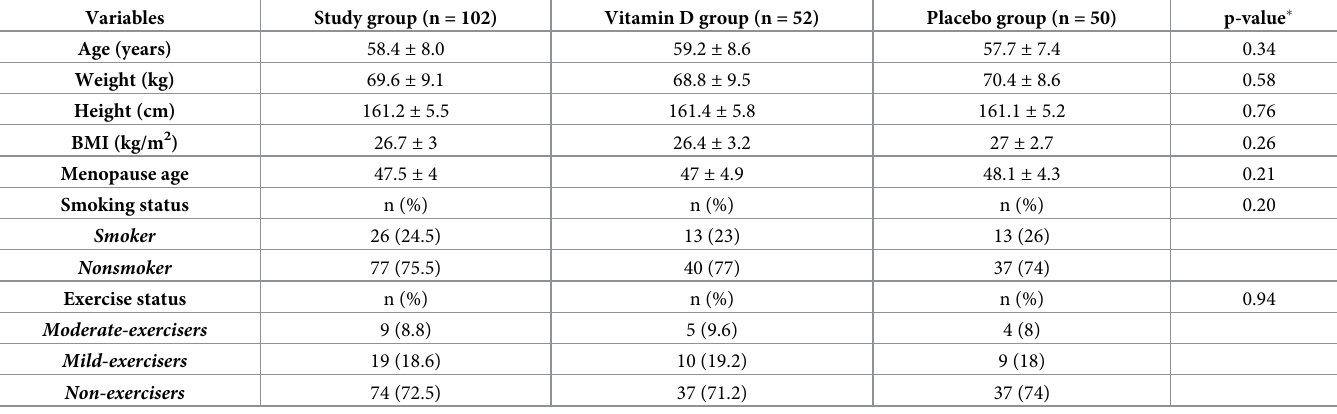
Table 2. Demographic parameters in